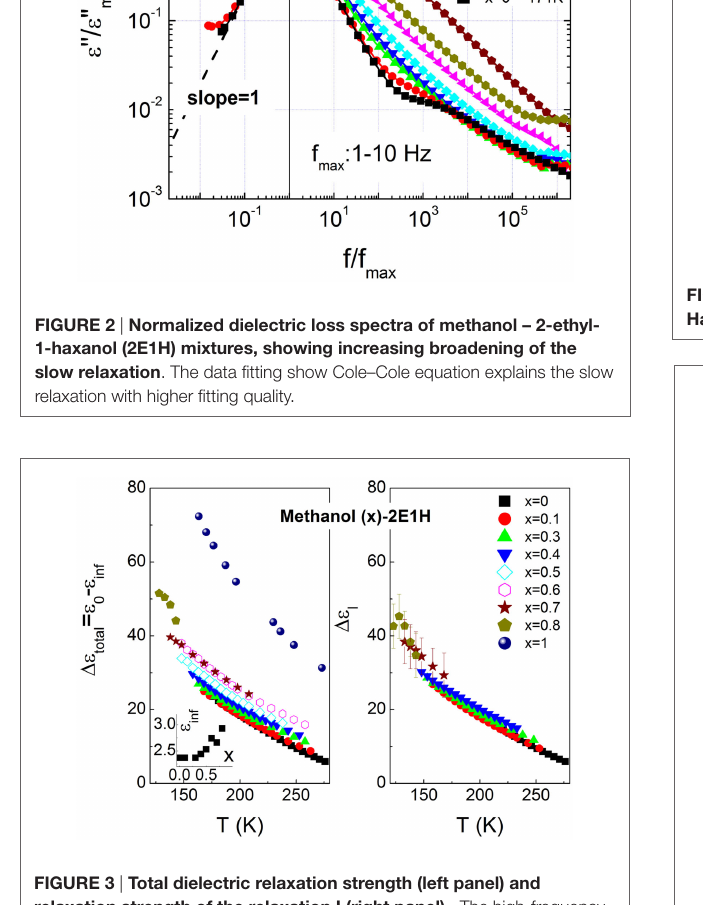
FigUre 3 | Total dielectric relaxation strength (left panel) and relaxation strength of the relaxation i (right panel) . The high-frequency dielectric constant is shown in the